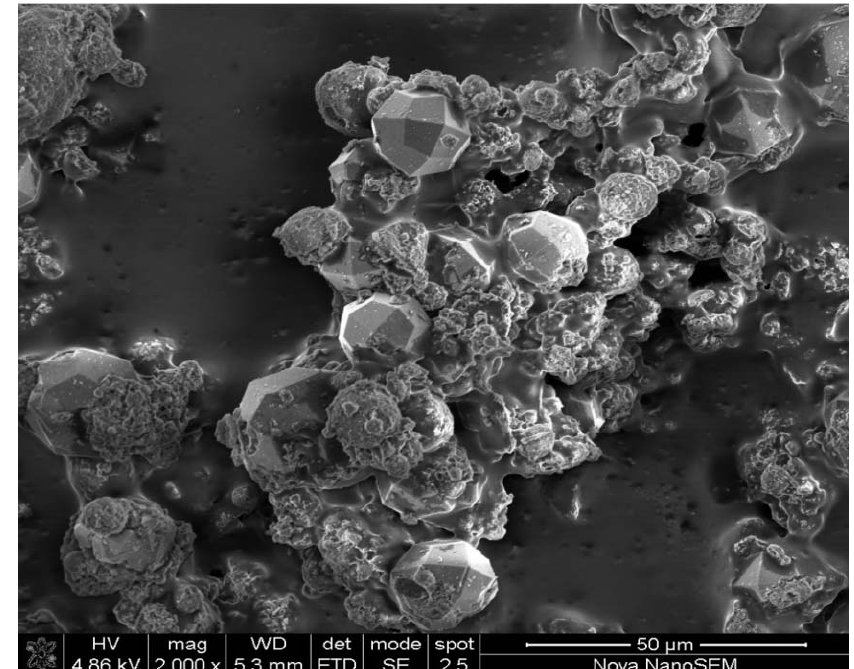
Figure 6. Micrographs taken of the products obtained after Run 7, at a magnification of 2000